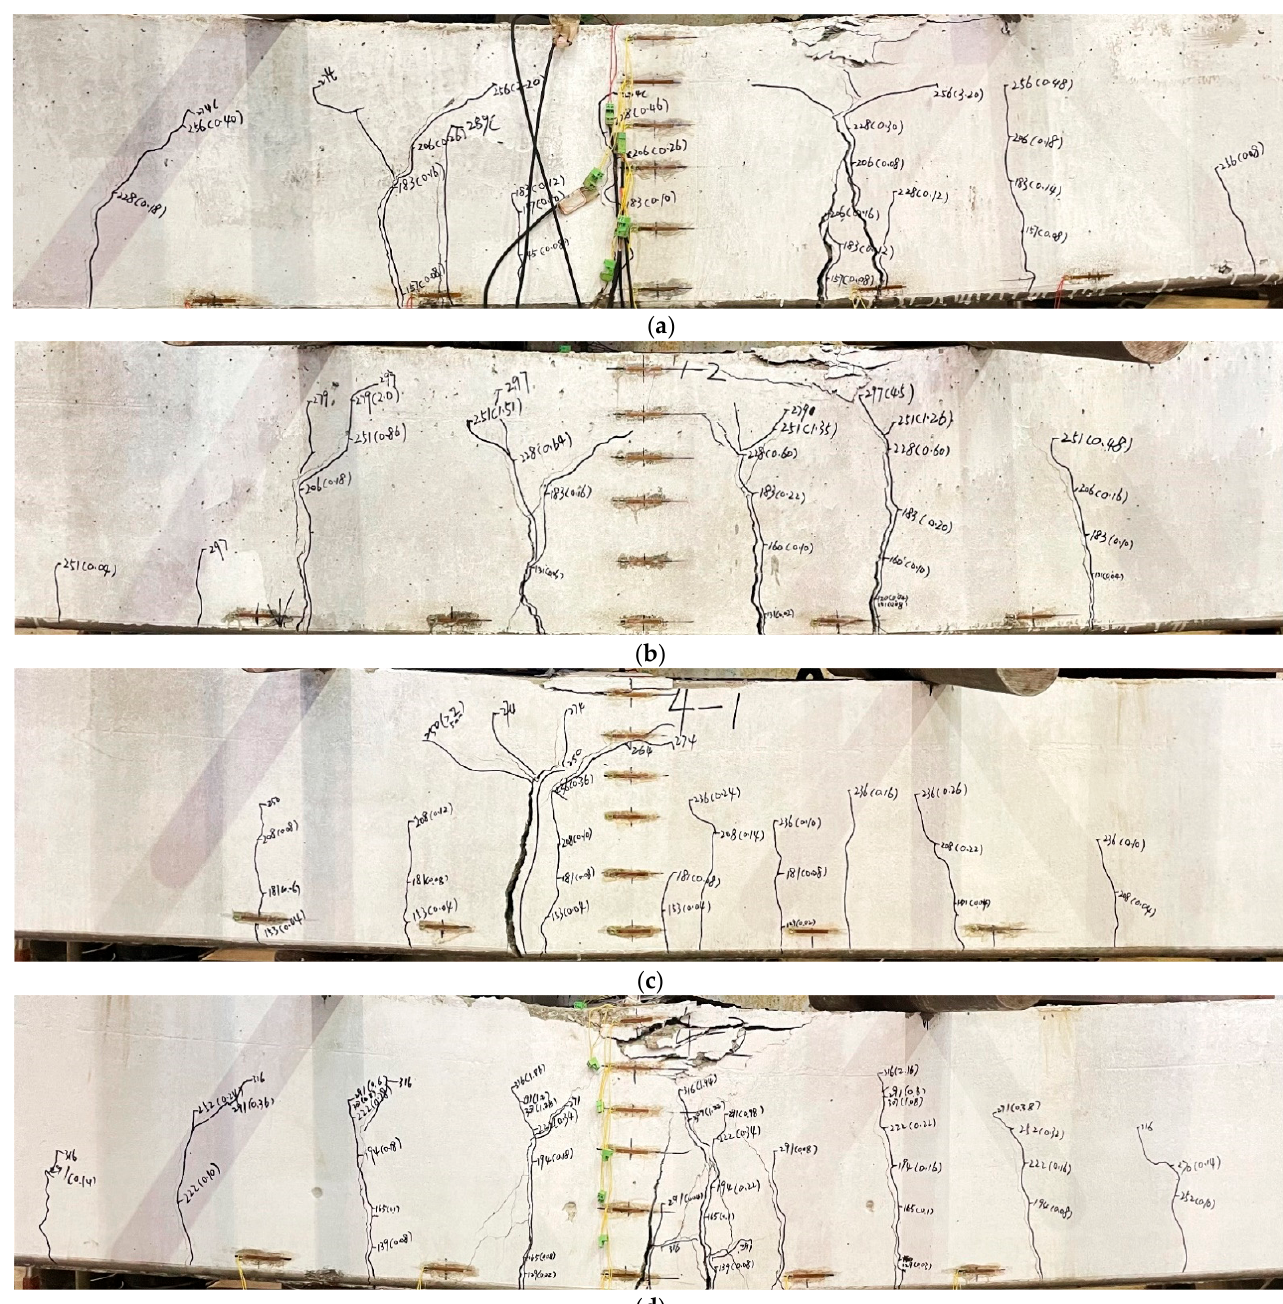
Figure 9. Distribution of cracks of specimens after failure. ( a ) Specimen PRS400A1. ( b ) Specimen PRS400A2. ( c ) Specimen PRS400B1. ( d ) Specimen PRS400B2.